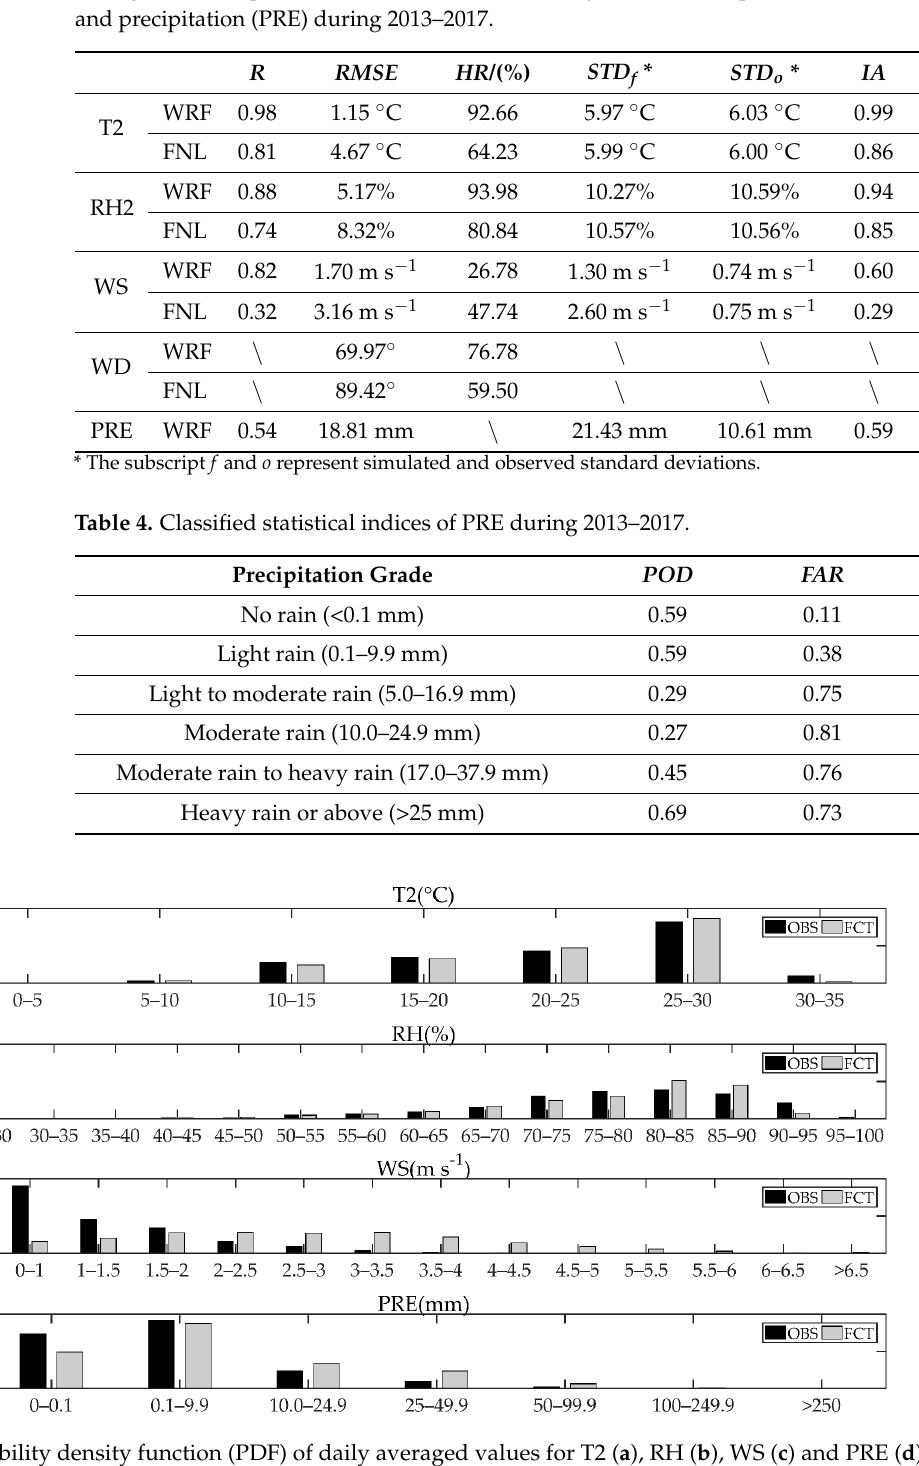
Table 3. Standard statistical indices of WRF and Final (FNL) results comparing observed daily